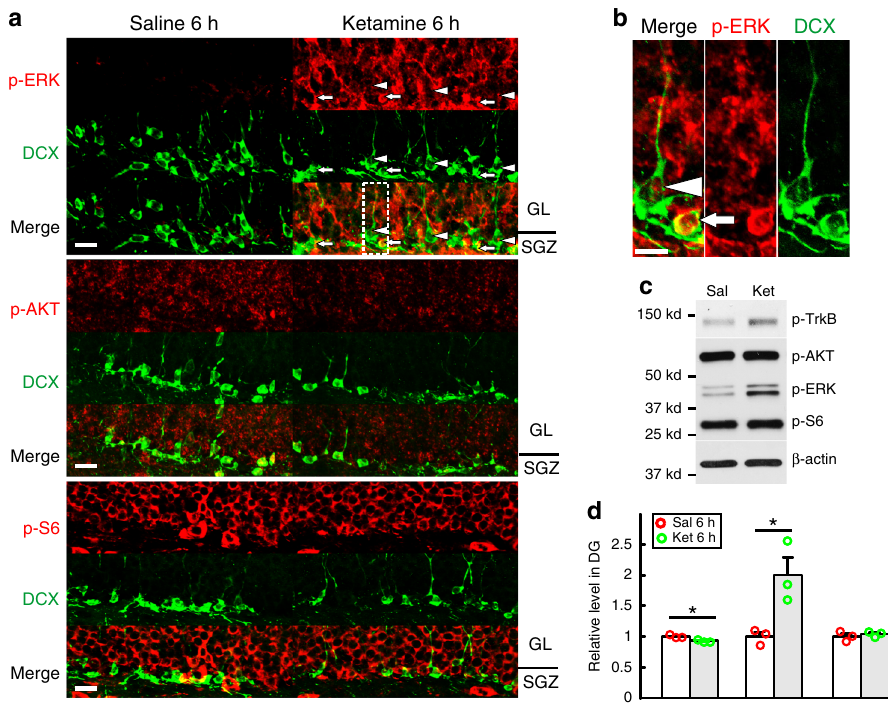
Fig. 6 Ketamine enhances ERK signaling pathway. a Confocal images show immuno-signal of p-ERK (red, upper panel), but not p-Akt (red, middle panel) or p-S6 (red, bottom panel), increases in both granular layer (GL) and subgranular zone (SGZ) of the DG six hours after one dose of ketamine treatment. Arrows denote the DCX+ cells (green) that are localized in SGZ and have a high level of p-ERK. Arrowheads highlight the DCX+ cells with long dendrites that have a modest increase of p-ERK. Scale bar, 20 µ m. b The image in the dash-line rectangle in (a) is magni fi ed showing a cell without dendrites (arrow) and one with long dendrites (arrowhead). They have varying ERK activation in response to ketamine. Scale bar, 20 µ m. c , d Immunoblots on p-TrkB, p-Akt, p-ERK and p-S6 in dissected DGs from mice after 6 h of ketamine treatment. The quanti fi cation of expression level for each protein, normalized by β -actin expression level, is shown in d ( n = 3 per group; * p = 0.0327 for p-AKT, * p = 0.0286 for p-ERK, p = 0.5336 for p-S6 by unpaired two-tailed t